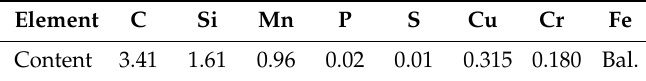
Figure 1. Microstructure of cast iron material. ( a ) Graphite structure with cast iron. ( b ) Matrix structure of matched cast iron. ( c ) Pearlite structure amplification with cast iron. of matched cast iron. ( c ) Pearlite structure amplification with cast iron. Table 1. Chemical compositions of nodular cast Table 1. Chemical compositions of nodular cast iron.